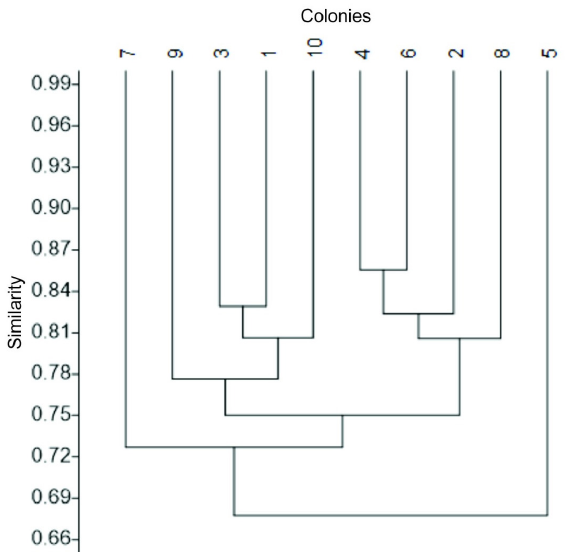
Fig 2. Similarity dendrogram (Bray-Curtis index and paired group algorithm) in the composition of pollen sampled in the colonies of Apis mellifera in a seasonal semideciduous forest in the State of Ceará, in the period from November 2012 to October 2013.